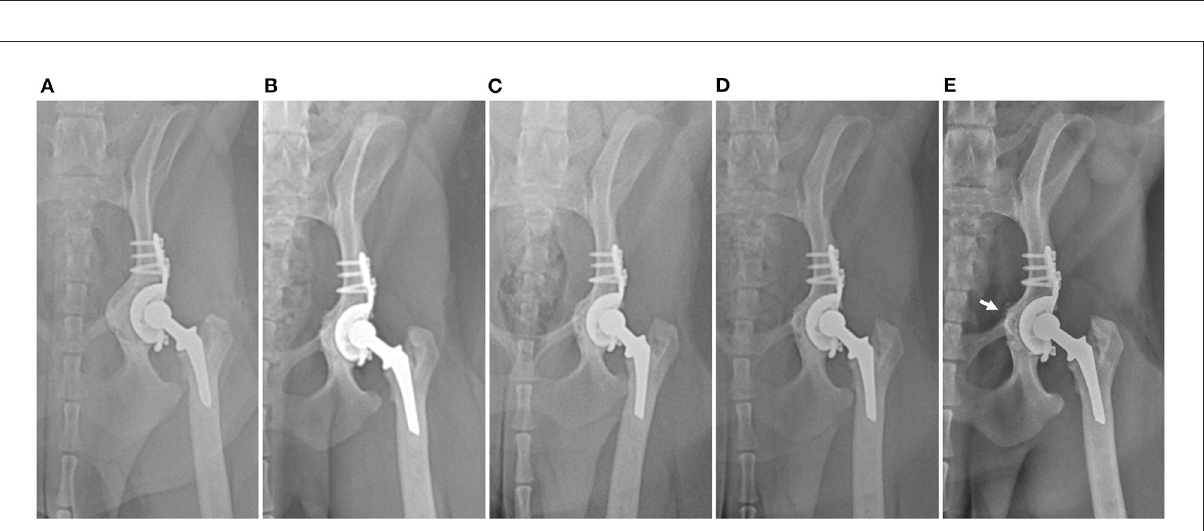
FIGURE3 Postoperative serial craniocaudal radiographs of the left hip with cage at subsequent follow-ups at (A) immediately postoperatively and (B) 5 months, (C) 15 months (D) 20 months, and (E) 39 months postoperatively. No evidence of loosening or change in implant position and gradual remodeling of medialized pelvic bone (arrow) can be observed on the